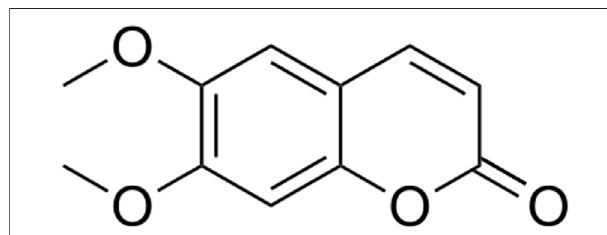
FIGURE 1 | Chemical structure of